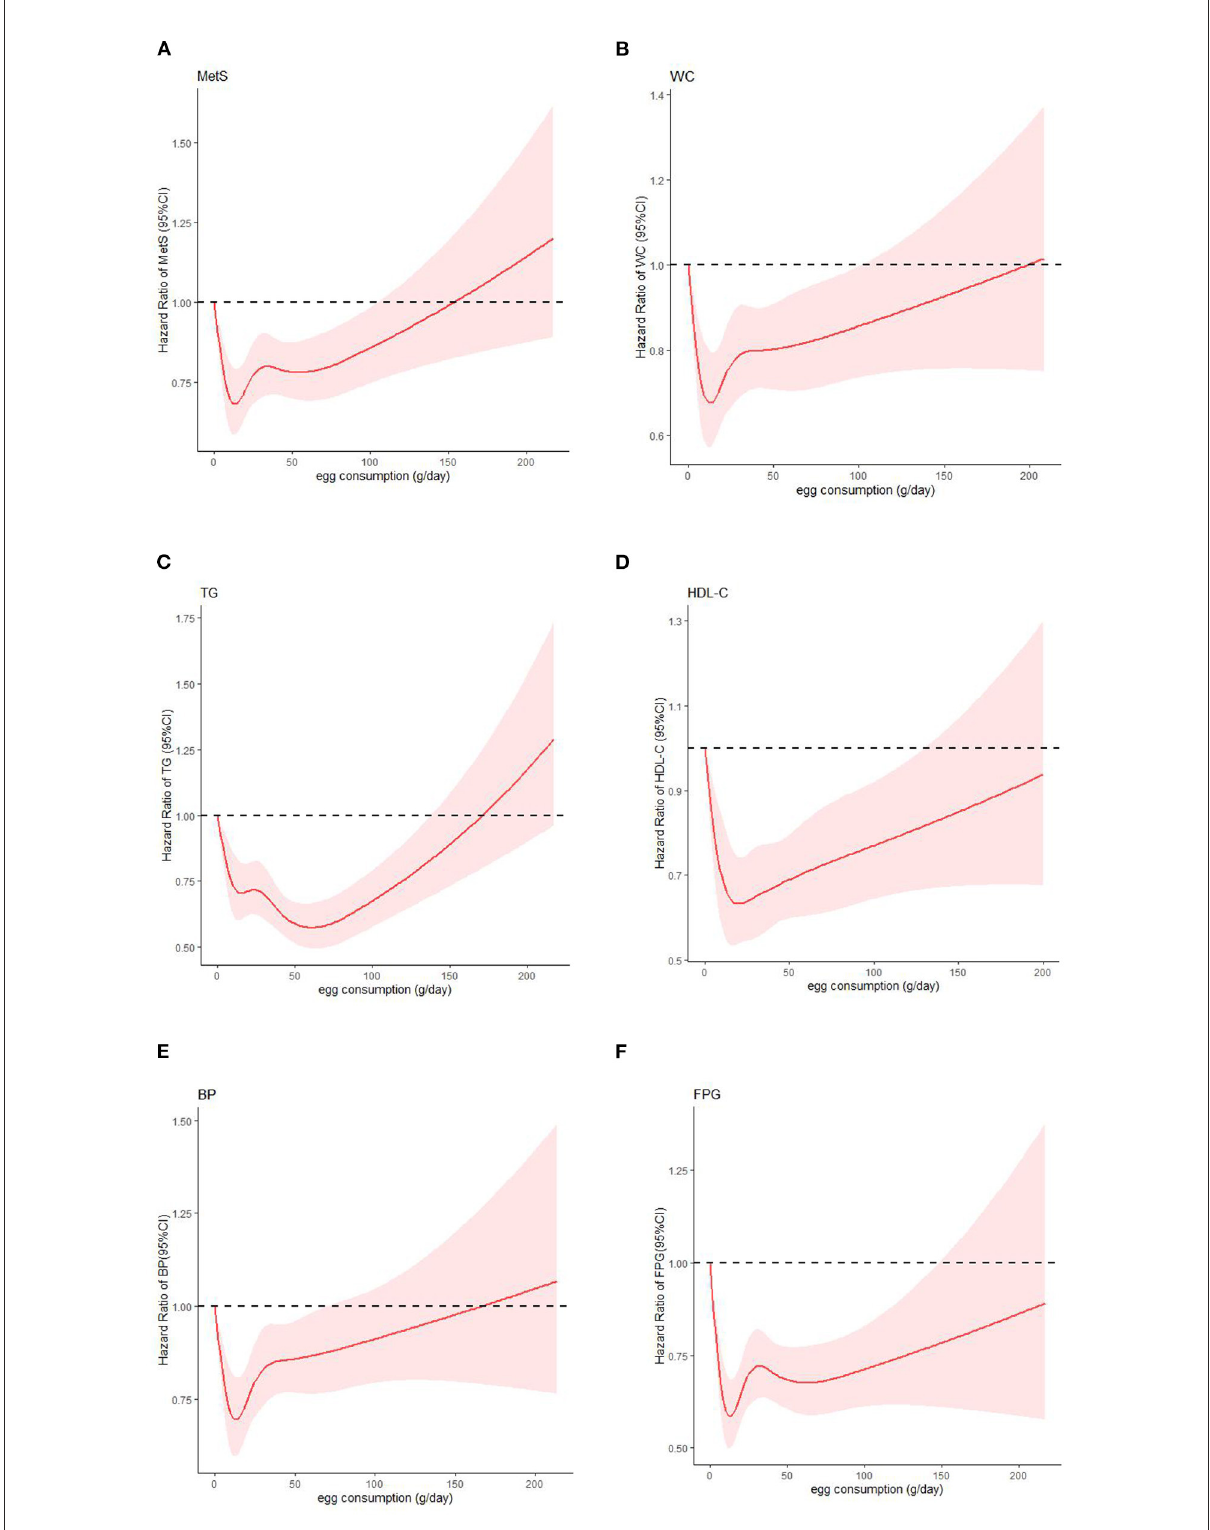
FIGURE2 Dose-response relationship of egg intake with CMFs: (A) MetS: metabolic syndrome; (B) WC: waist circumference; (C) TG: triglyceride; (D) HDL-C: high density lipoprotein cholesterol; (E) BP: blood pressure; (F) FPG: fasting plasma